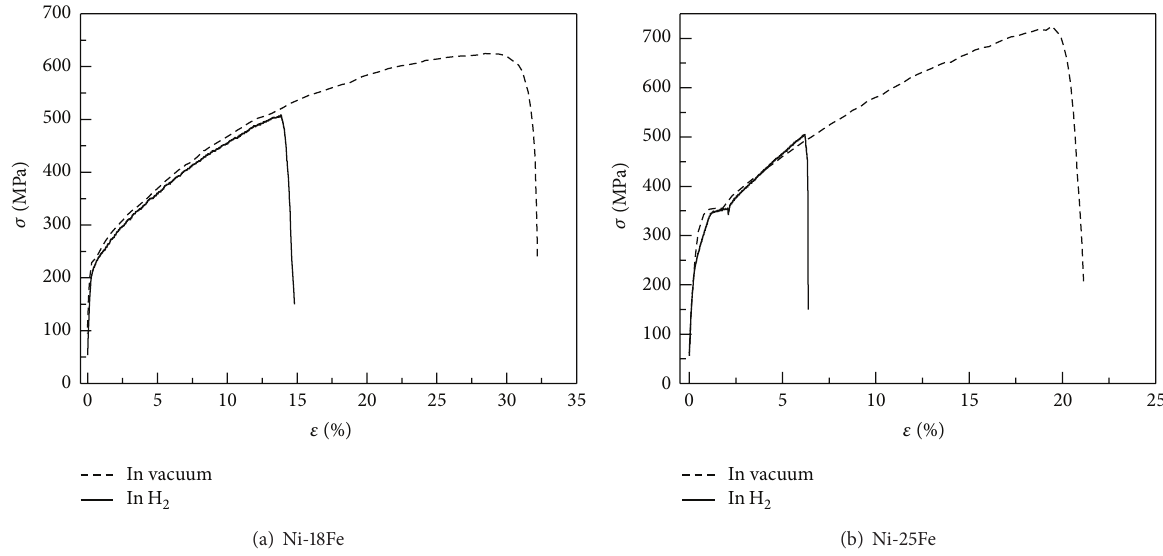
Figure 1: Engineering stress-strain curves for the ordered Ni 3 Fe alloys with different stoichiometry when tested in vacuum and H 2